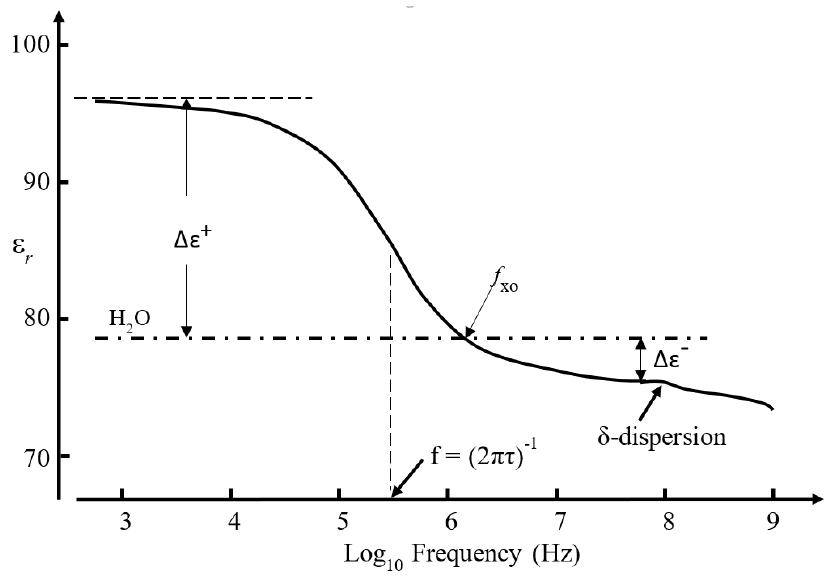
Figure 8. The β -dispersion and δ -dispersion, arising from orientation polarization of the protein and protein-bound water, respectively, exhibited by 0.18 mM BSA (based on Moser et al. [50] and Grant et al. [51]). The radian frequency of orientation relaxation for BSA is given by the reciprocal of its relaxation time τ . For frequencies below f xo (~1 MHz) the relative permittivity ε r of the BSA solution exceeds that of pure water, and is less than this above f xo. According to Equation (11) the dielectric increment ∆ ε + and decrement ∆ ε − , respectively, specify the frequency ranges where positive and negative DEP, respectively, should be observed for monomer BSA in aqueous solution.